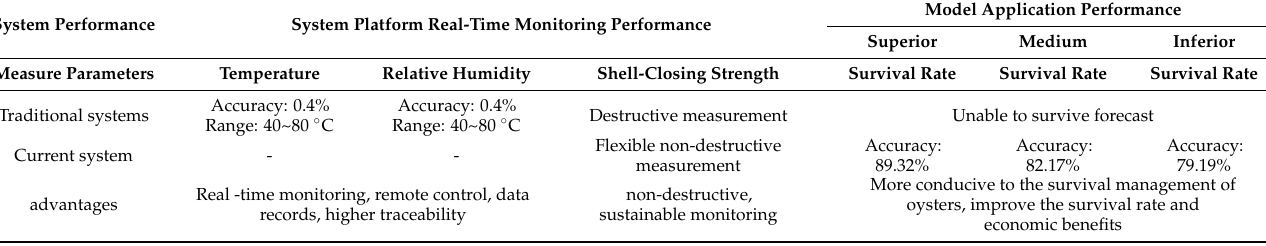
Table 2. Overall system